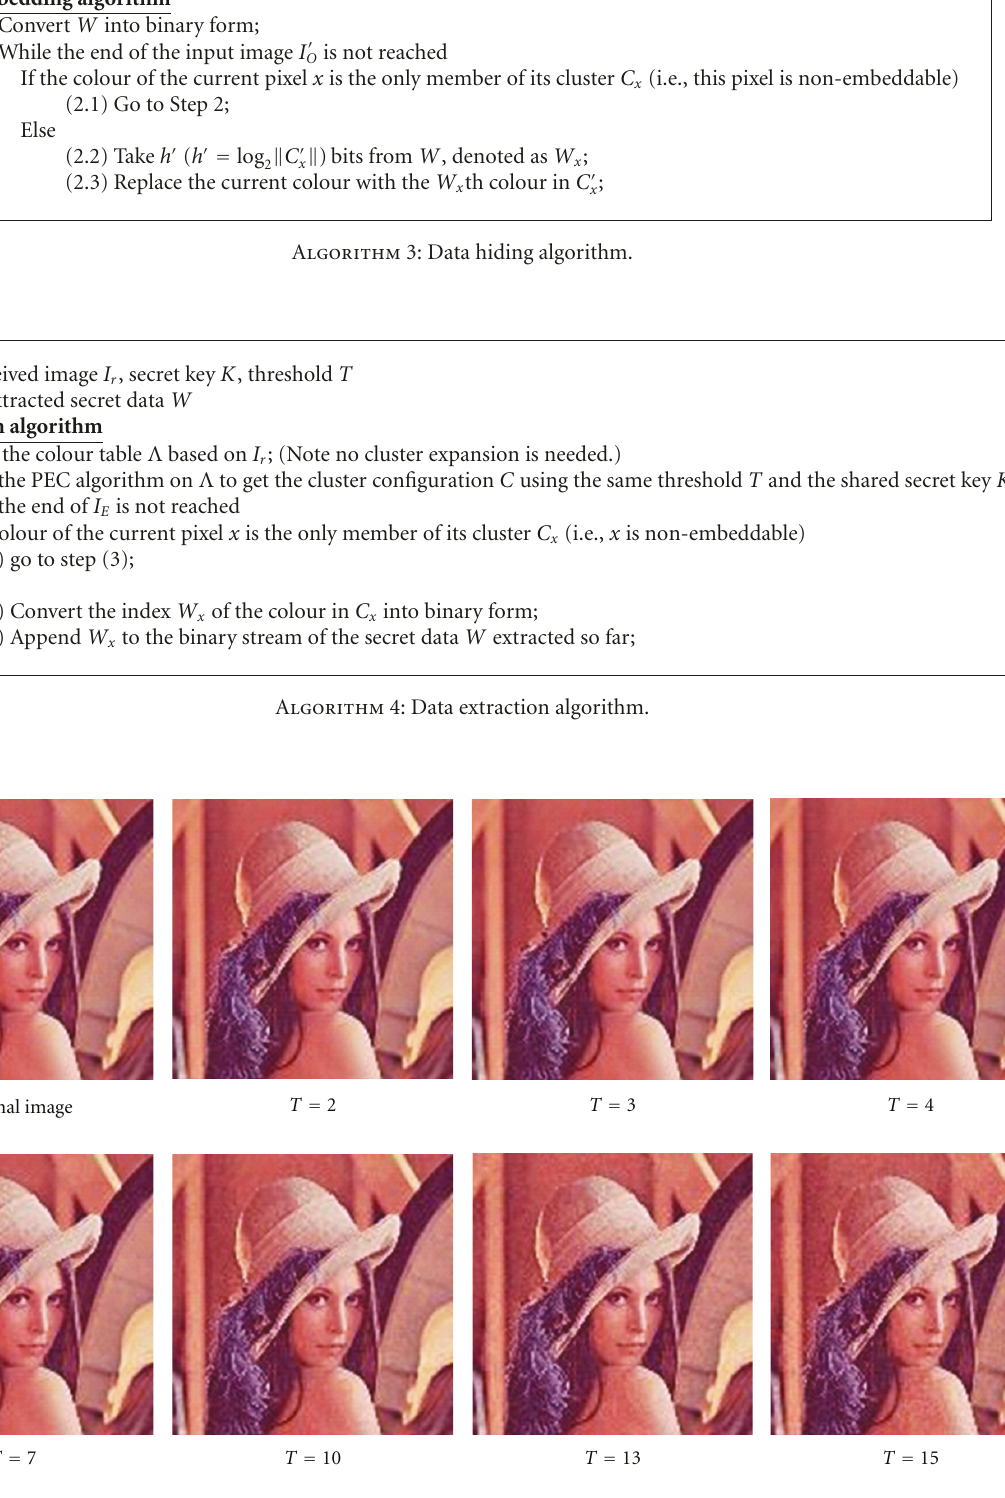
Figure 3: The original Lena image and the stego-images with di ff erent distance